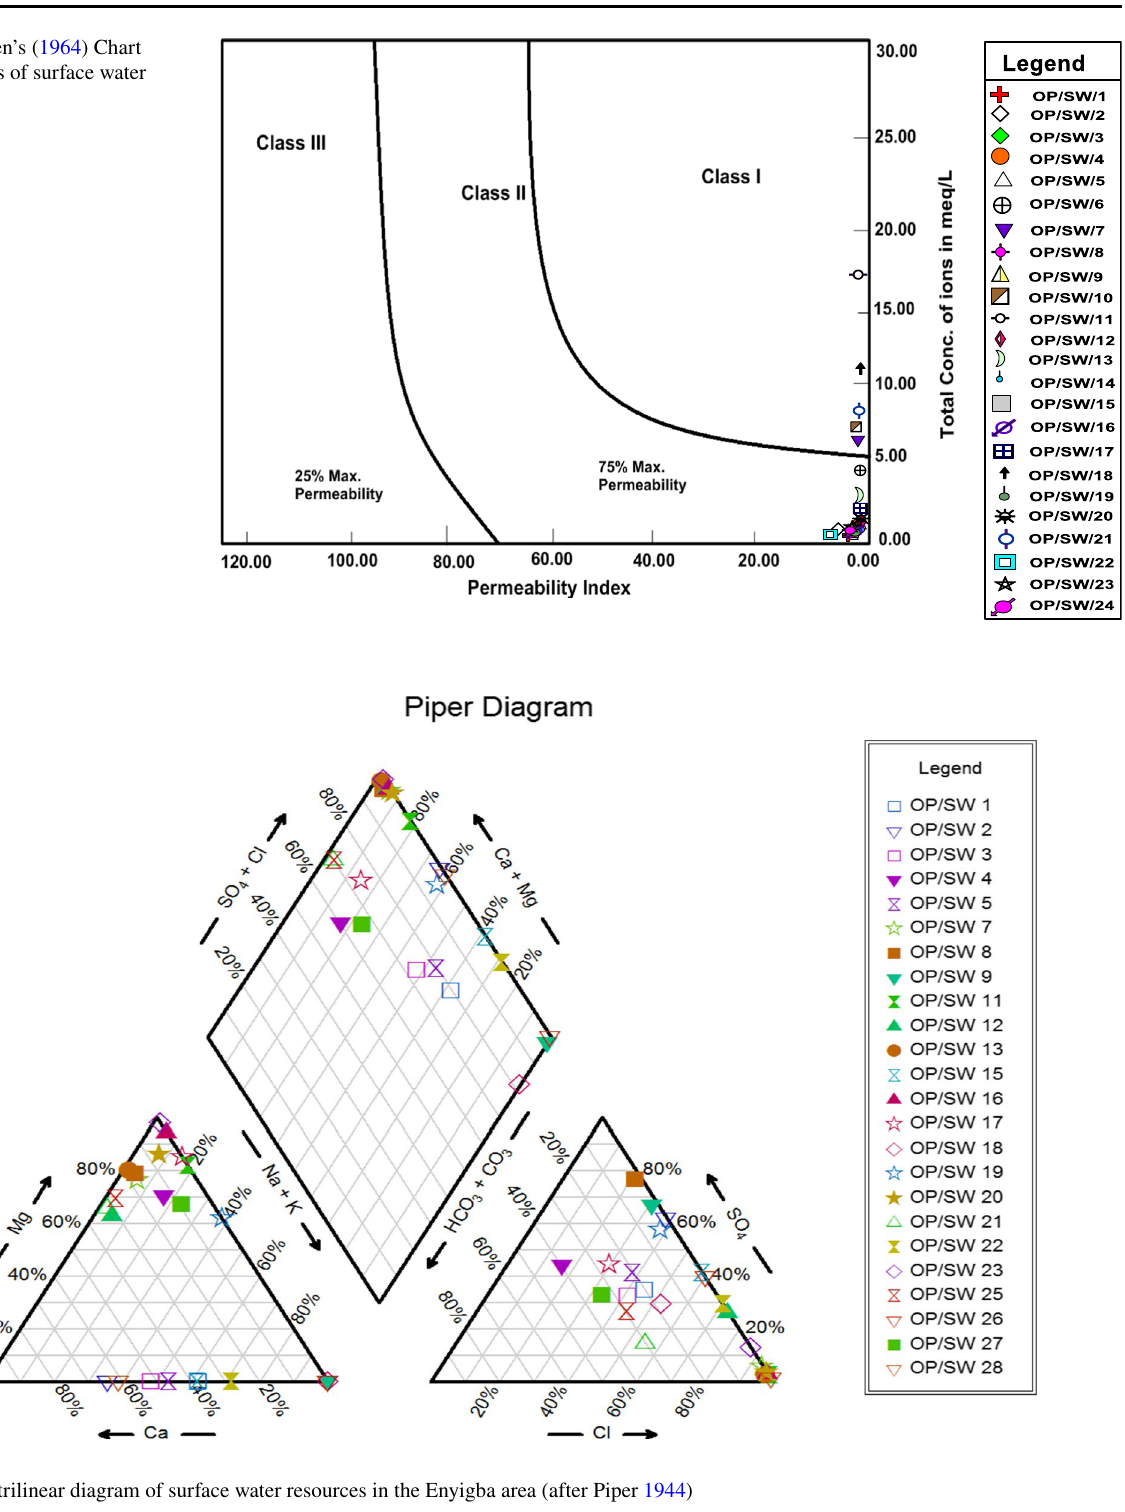
Fig. 7 Piper trilinear diagram of surface water resources in the Enyigba area (after Piper